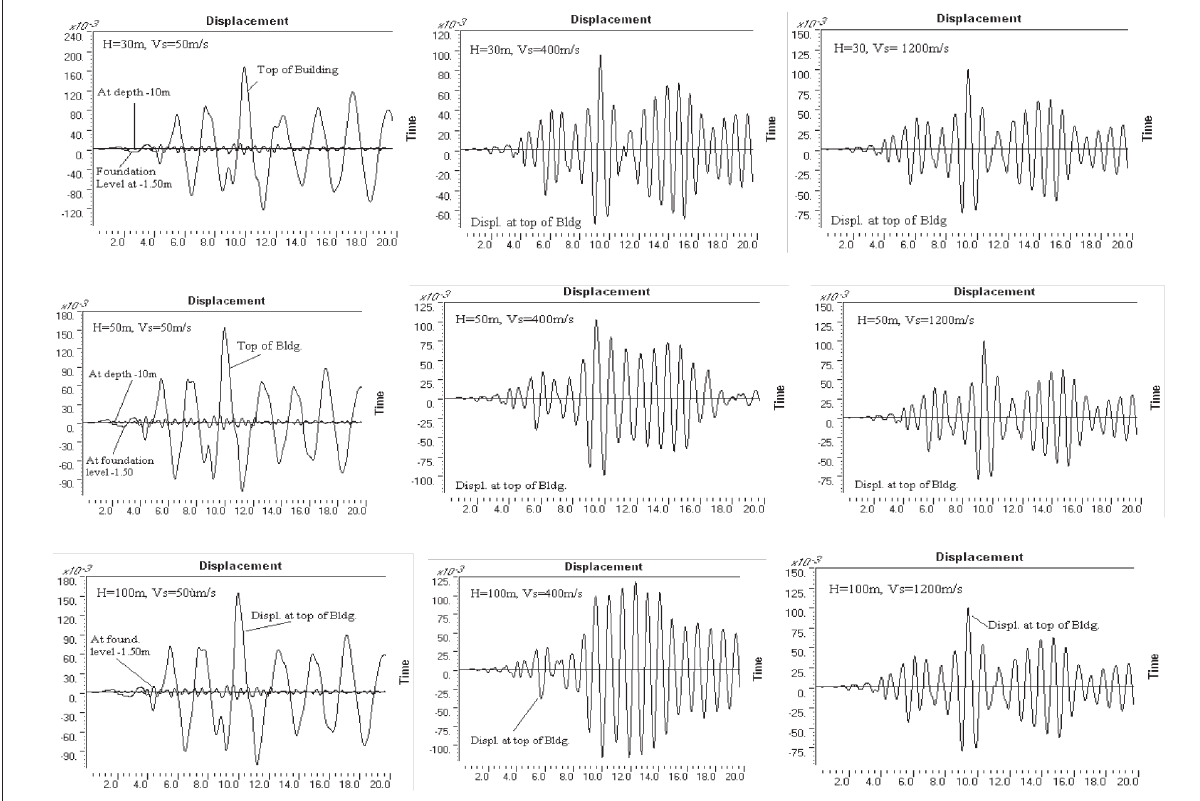
(cid:1)(cid:6)(cid:3) (cid:22)+(cid:6)7(cid:7) (cid:31)?%(cid:10)(cid:31)(cid:1)(cid:6)2+(cid:6)(cid:2)D(cid:3)(cid:15)’(cid:31)0(cid:31)(cid:6)(cid:6)3(cid:6)425(cid:20)(cid:6)(cid:19)(cid:13)(cid:9)1(cid:17)(cid:20)6(cid:20)75(cid:17)5(cid:18)(cid:6)5(cid:21)(cid:6)(cid:13)2(cid:20)(cid:17)(cid:20)(cid:29)5(cid:17)5(cid:18)(cid:6)89(cid:18)(cid:19)9(cid:29)(cid:22)(cid:18)(cid:6):(cid:6)(cid:27)"".(cid:1)(cid:6)8(cid:7)(cid:12)(cid:6);555(cid:1)(cid:6)(cid:17)(cid:7)(cid:6)<(cid:1)(cid:6)(cid:27)==:(cid:27).(cid:25)